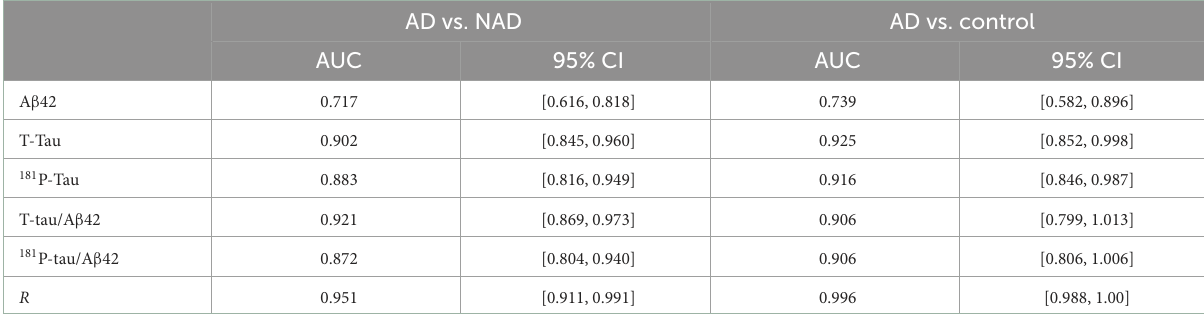
TABLE 2 AUCs and corresponding 95% CIs.